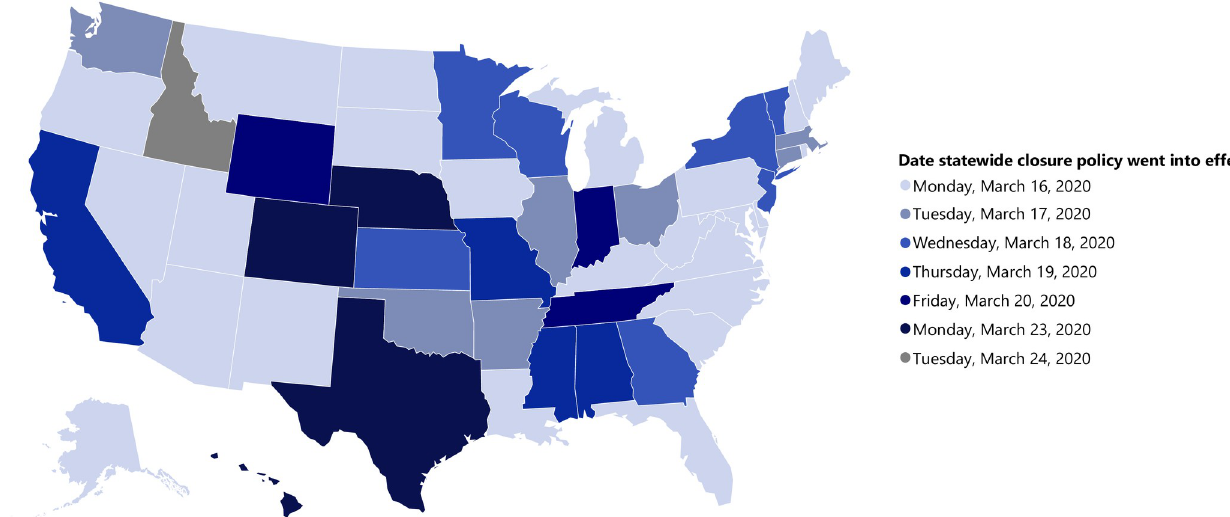
Fig 2. Effective date of statewide coronavirus disease 2019 public K-12 school closure policies–United States, March 2020. Data Sources, Reference, & Notes: Data were collected via daily searches of publicly available online content. A standard set of search terms were used to identify COVID-19-related public school closures lasting � 1 day. Official state-level health and education department websites, and school and district-level websites were also searched. The map shows the effective date of state-level closure policies for the academic year 2019–2020 for public K-12 school districts in which schools are physically closed for students. School districts may be using distance learning to continue education from home. Orders and recommendations for statewide closure originated from state governors and/or state education departments.